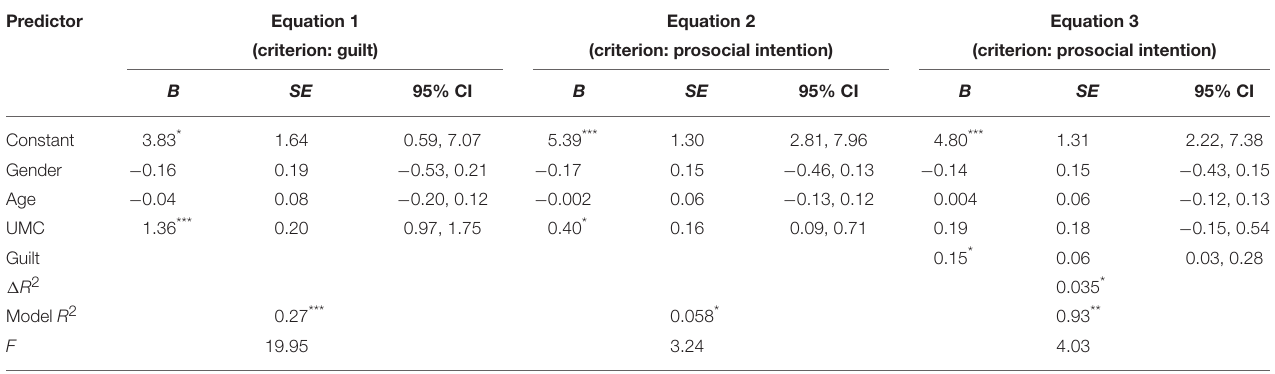
TABLE 3 | Results of the regression analysis of mediation ( N = 162). Predictor